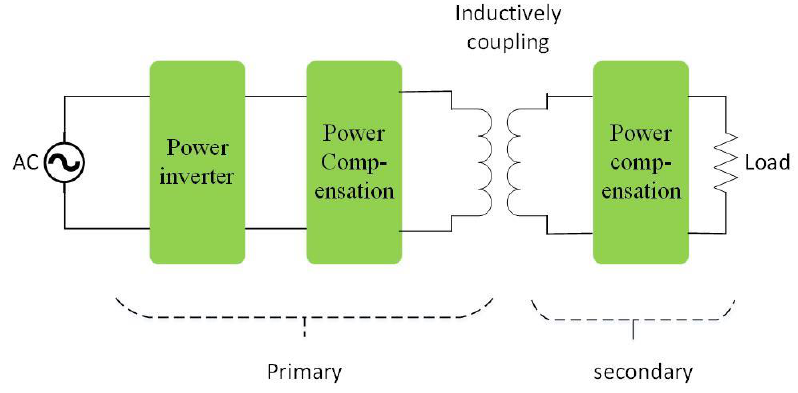
Figure 12. Induction wireless power transmission.